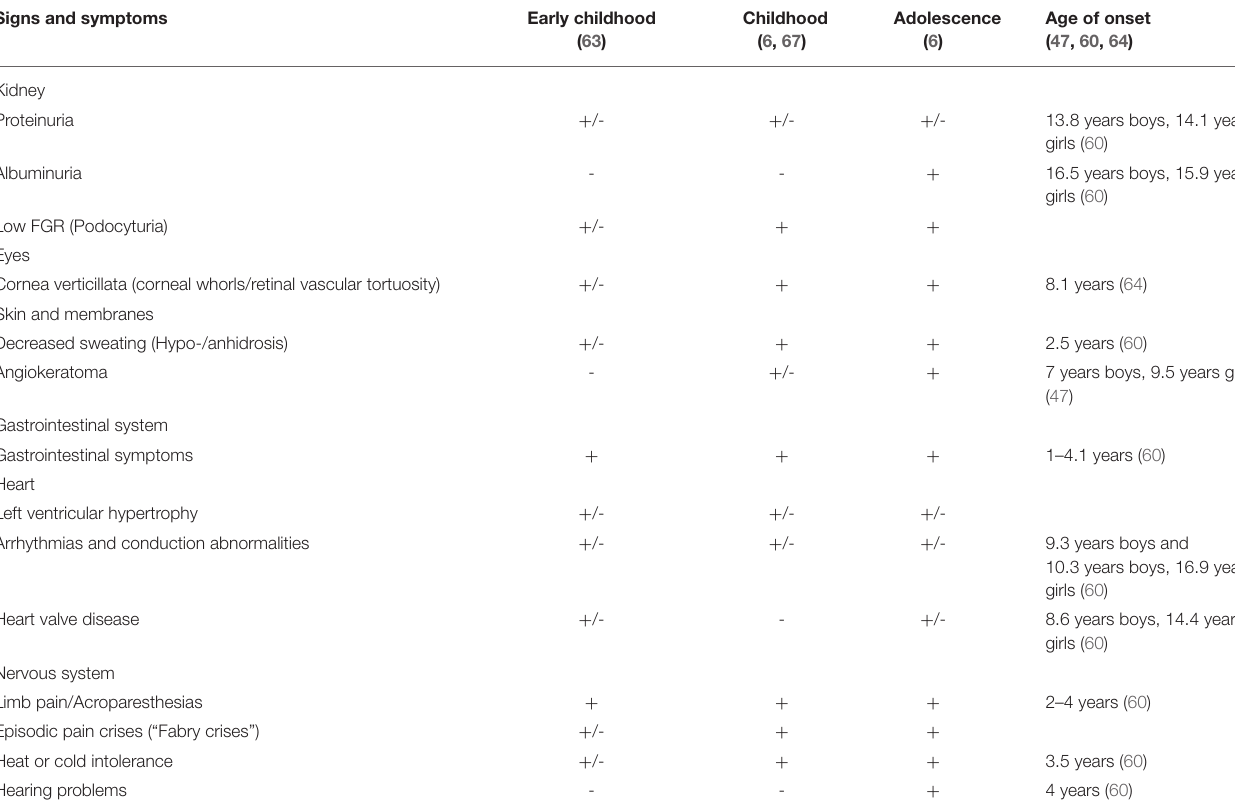
TABLE 2 | Signs and symptoms of Fabry disease, stratified by age. Signs and